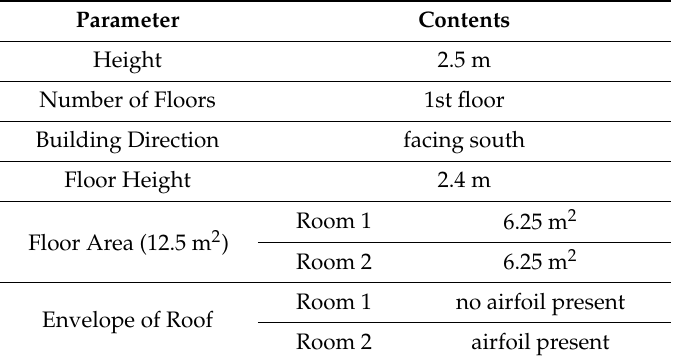
Table 4. Specifications of the mock-up rooms.